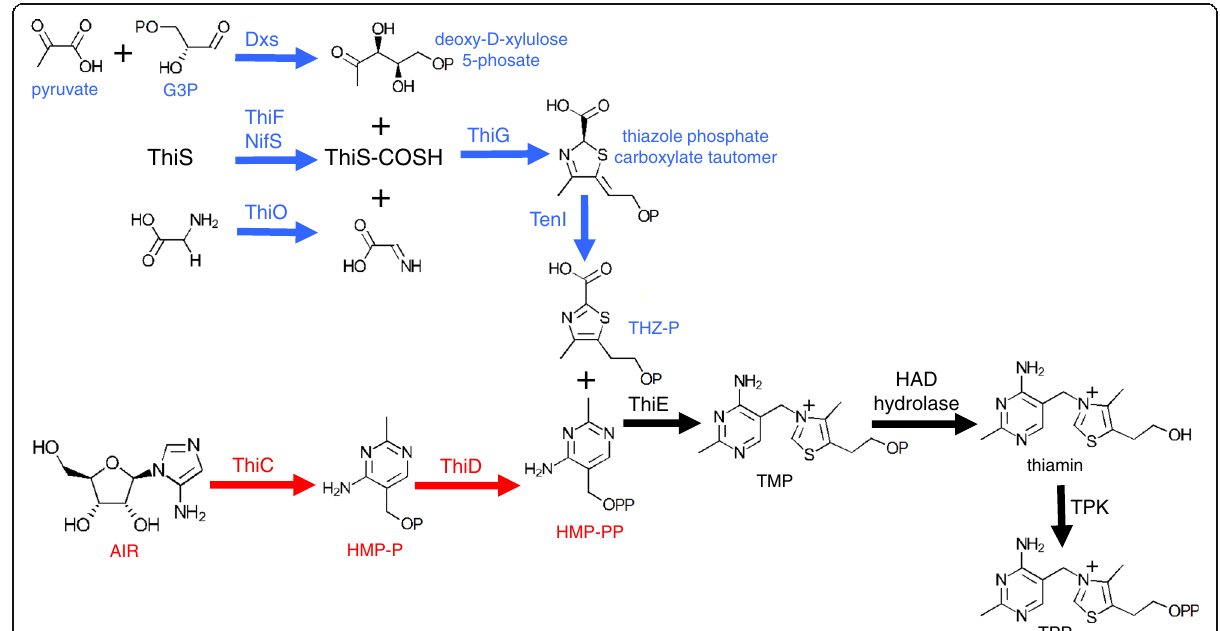
Fig. 3 Predicted thiamin biosynthesis pathway in P. apiarius NRRL B-23460. Pathways involved in thiazole biosynthesis are highlighted in blue and pathways involved in pyrimidine biosynthesis are shown in red. The steps in black correspond to the coupling of the thiazole and pyrimidine moieties, and the formation of the active cofactor TPP